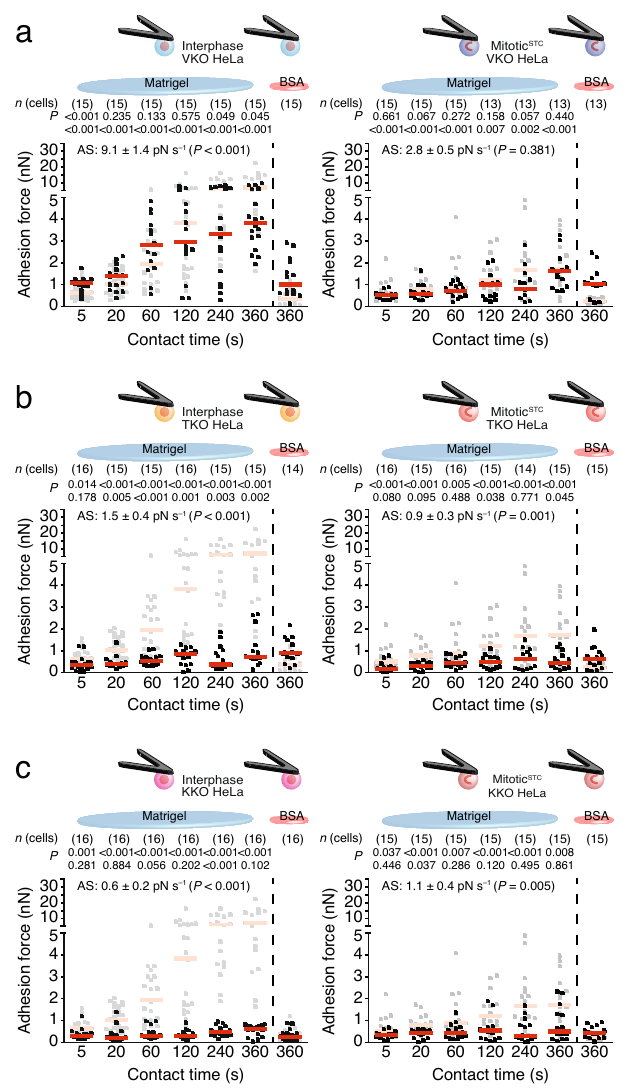
Fig. 3 | Adhesome proteins differentially regulate cell – ECM in interphase and mitosis. Adhesion forces to Matrigel or BSA of interphase (left) and mitotic STC (right) HeLacellsdepleted from vinculin(VKO) ( a ),talin1/2(TKO) ( b ),or kindlin1/2 (KKO) ( c ) to Matrigel or BSA after given contact times. As reference, cell – ECM adhesion forces of wildtype HeLa cells are given in gray (Fig. 1a). Dots represent adhesion forces between single cantilever-bound and substrate-spread cells, red bars their median values and n (cells) the number of independent cells in at least three independent experiments. AS-values give the adhesion strengthening rate as theslope(±SE)ofalinear fi tthroughadhesionforcesforallcontacttimeswiththe P value comparing the AS-value to the reference data (Supplementary Fig. 6). Top row P values compare the displayed data with the reference data. Bottom row P values compare displayed adhesion forces with adhesion forces of wildtype HeLa cells to BSA(left, SupplementaryFig. 2b)or with the adhesionforces of interphase cells of the respective HeLa cell line (right, data taken from left panel). P values comparing adhesion forces were calculated using two-tailed Mann – Whitney tests and P values comparing AS-values were calculated by two-tailed extra sum of squares F